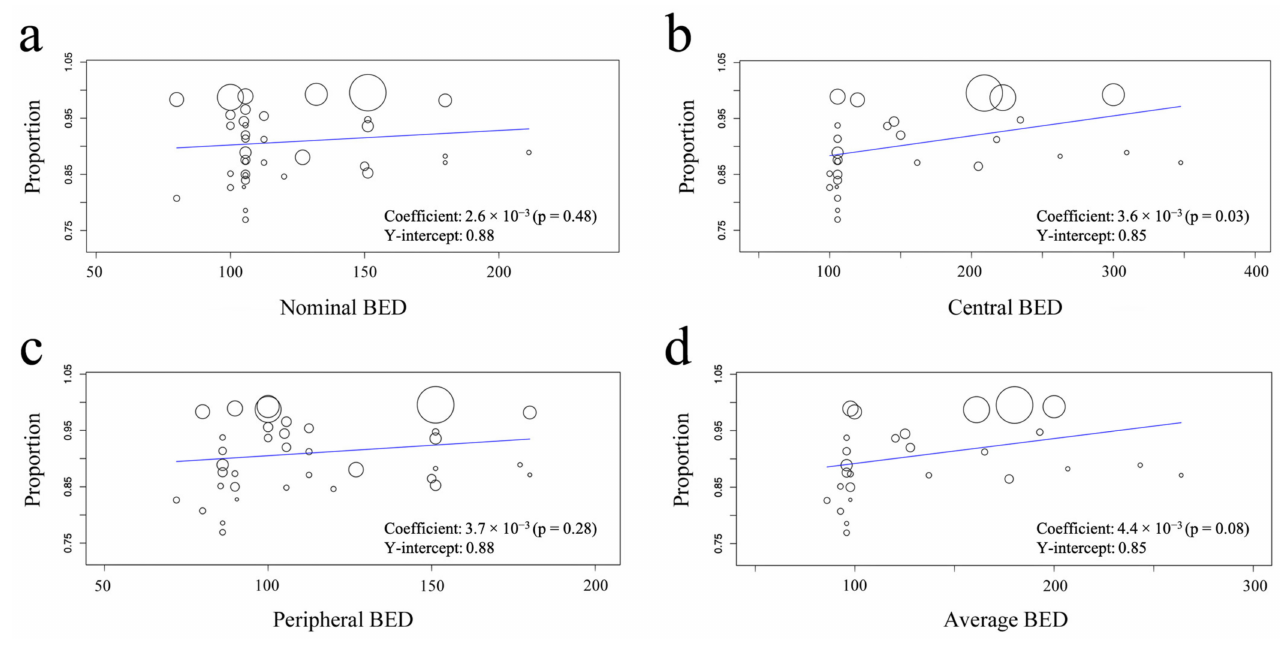
Figure 3. Univariate meta-regression analysis of 3-year local control rate according to ( a ) nominal, ( b ) central, ( c ) peripheral, and ( d ) average